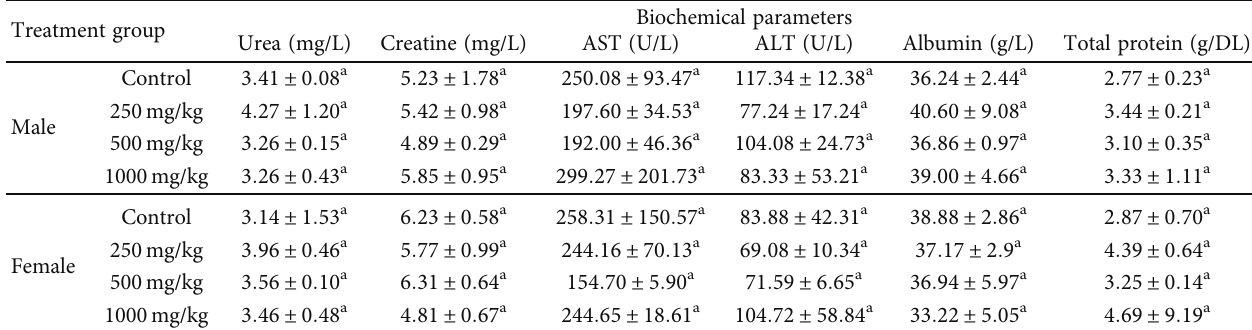
Biochemical parameters